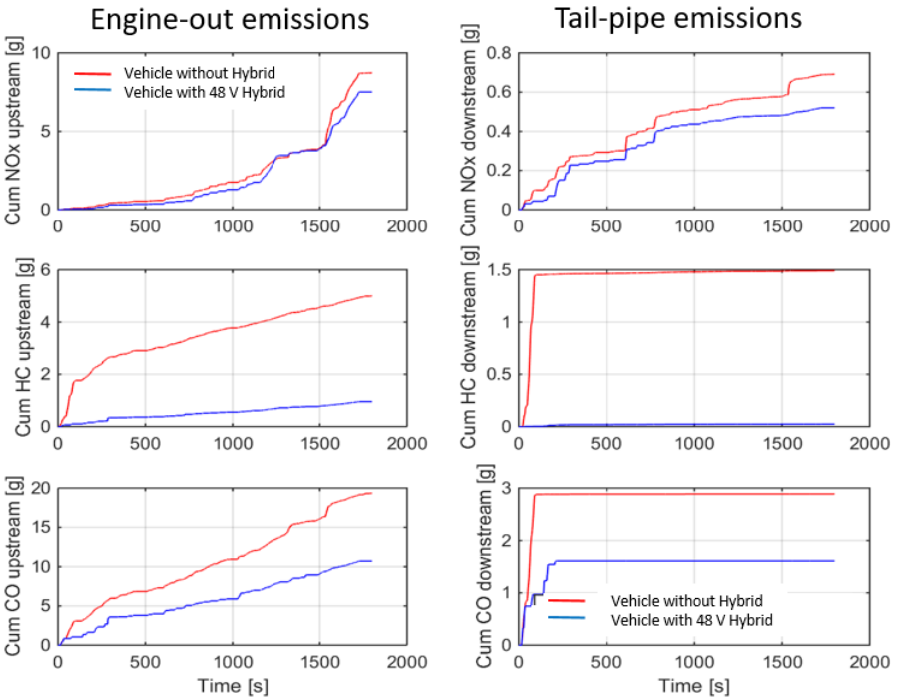
Figure 7. Engine-out and tailpipe emissions by hybridization coverage of the operating points of CN35 engine on cold WLTC with 48 V P2 Parallel HEV configuration.